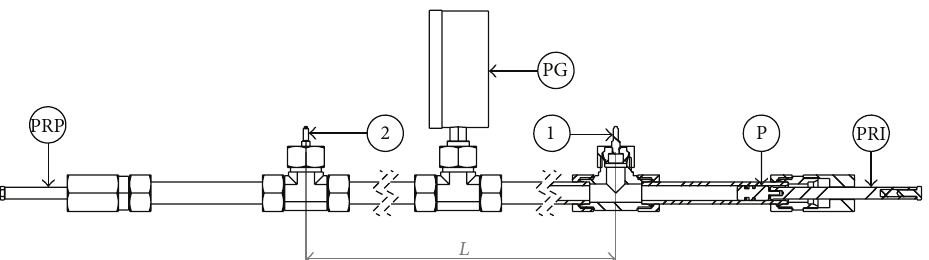
Figure 3: Compressibility measuring device.